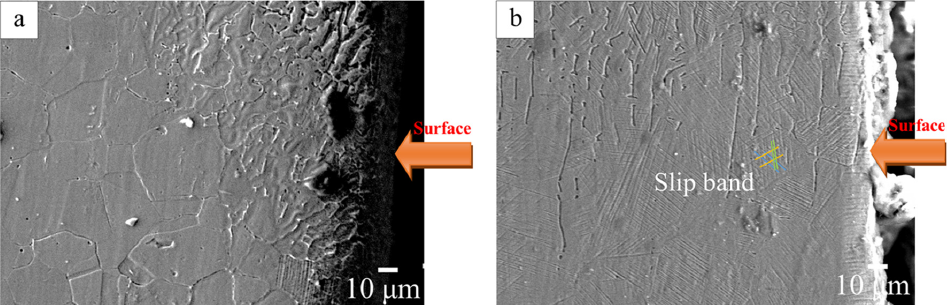
Figure 6. SEM images of the microstructure of cross sections of the heat-affected zone of the 316L stainless steel welded samples after different laser shock peening: ( a ) matrix and ( b ) peening three times.